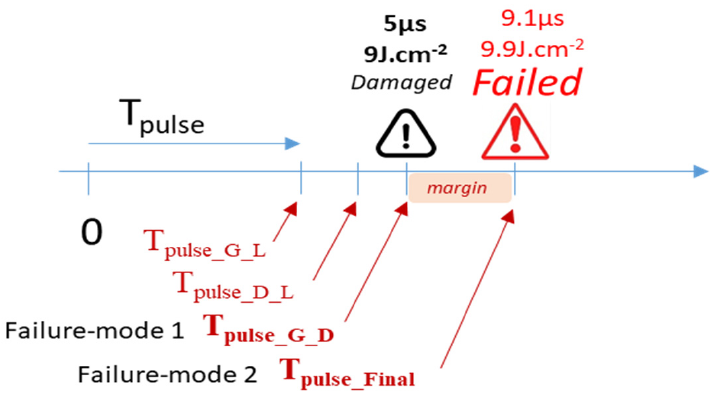
Figure 6. Timeline illustration exhibiting the main pulses: G_L, gate_leakage, D_L, drain_leakage, G_D, gate-damage; FTS, pulse_final.